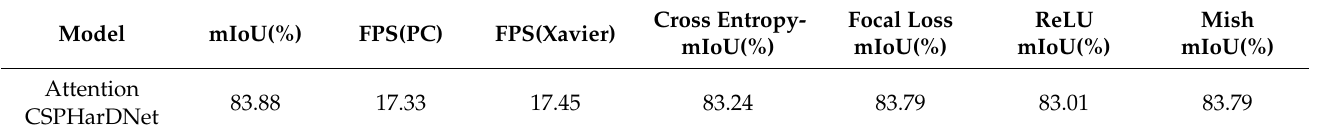
Table 3. Object detection performance and speed evaluation